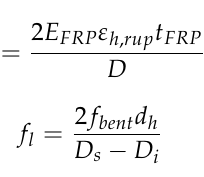
 Figure 7. Correlation between the present confined strain model and that proposed by Mander et al. [92] for confined concrete.